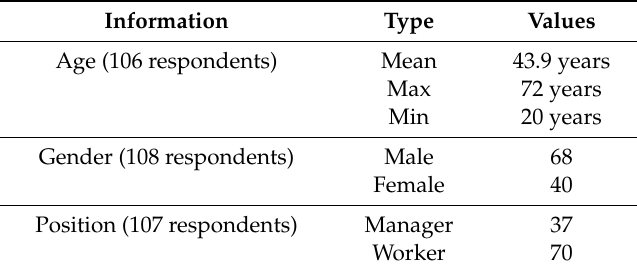
Table 3. Background information of the interviewed sample.